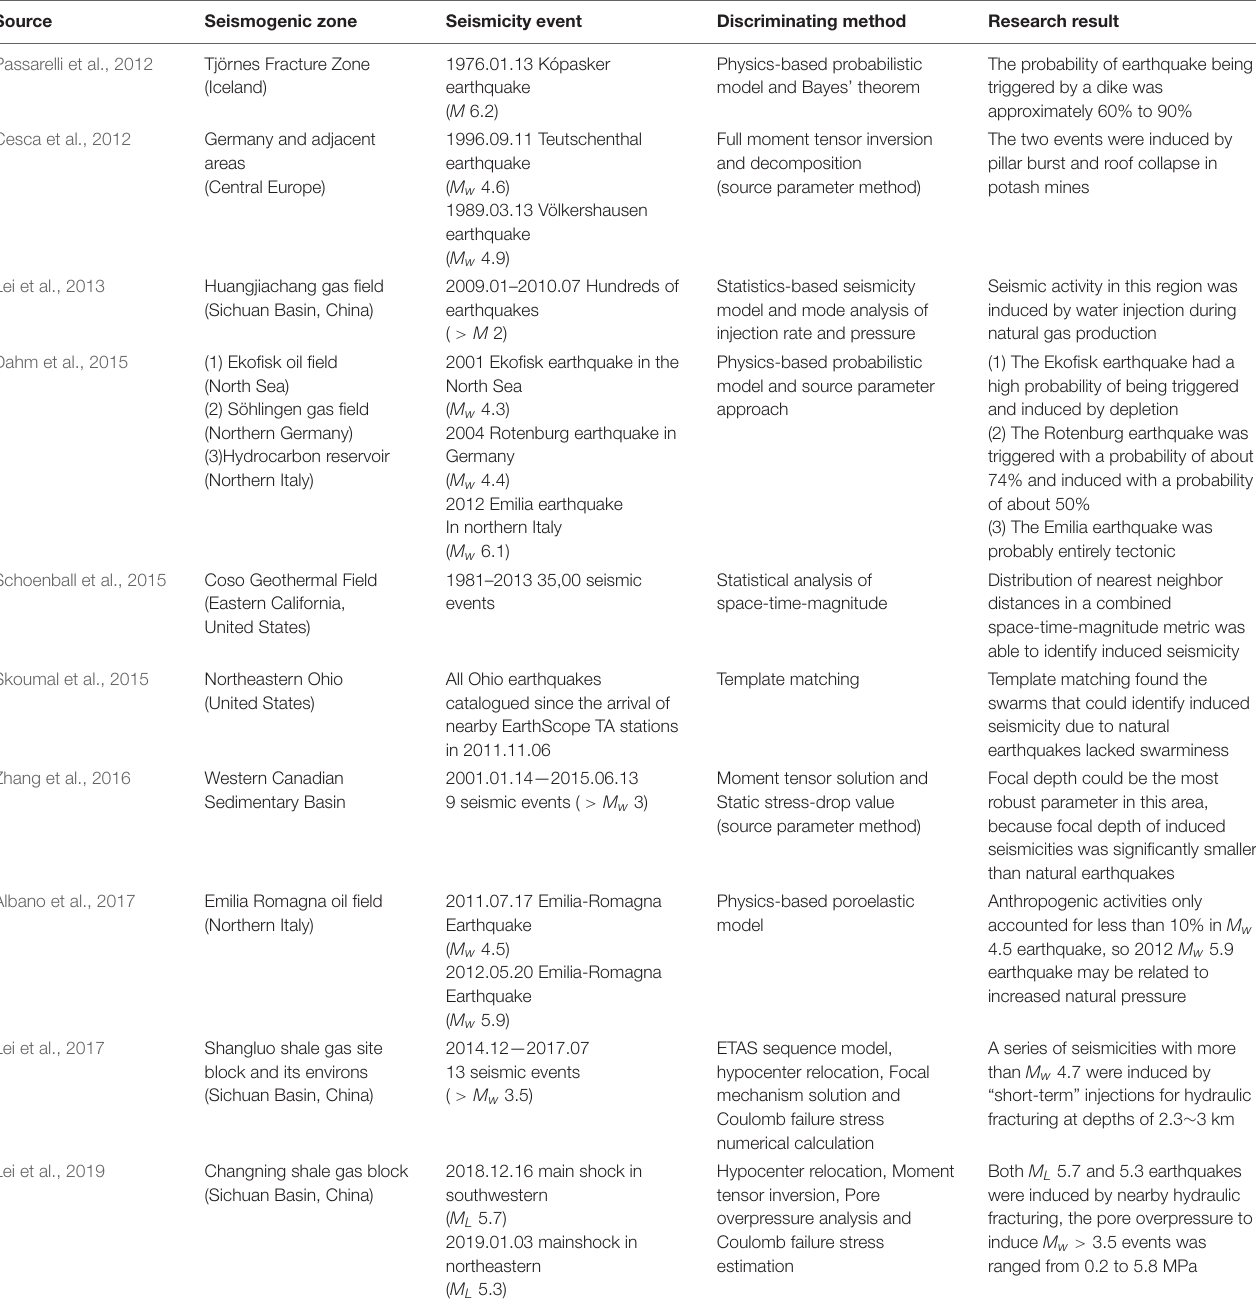
TABLE 2 | Discrimination of natural and induced seismicity in some typical